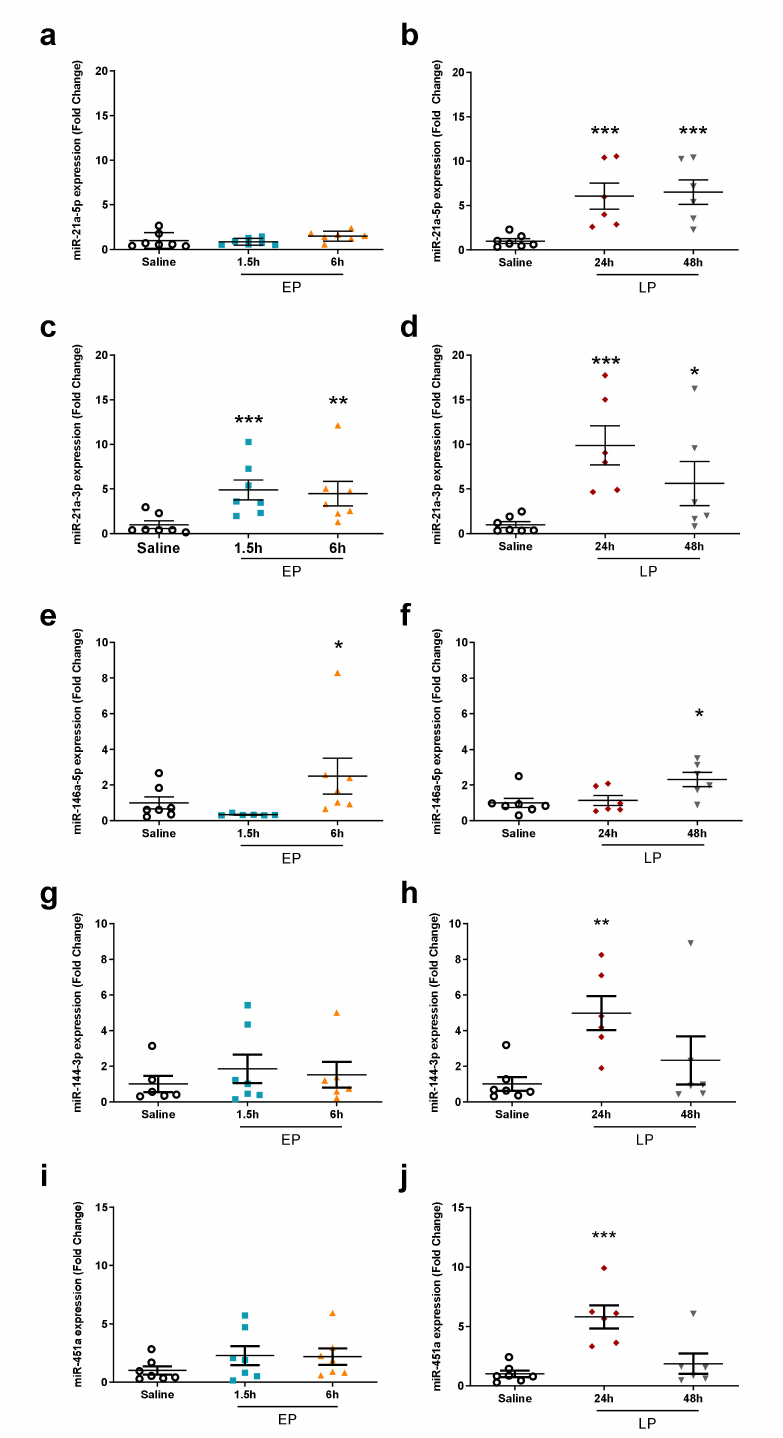
Figure 5. qPCR validation of miRNAs upregulated during the late phase on the microarray. The relative expression of miRNAs was normalized to let-7g-5p (fold changes vs. saline). Left column: EP, right column: LP. ( a , b ) miR-21a-5p; ( c , d ) miR-21a-3p; ( e , f ) miR-146a-5p; ( g , h ) miR-144a-3p; ( i , j ) miR-451a. Data are expressed as mean ± SEM; one-way ANOVA; *: p < 0.05, **: p < 0.01, ***: p <